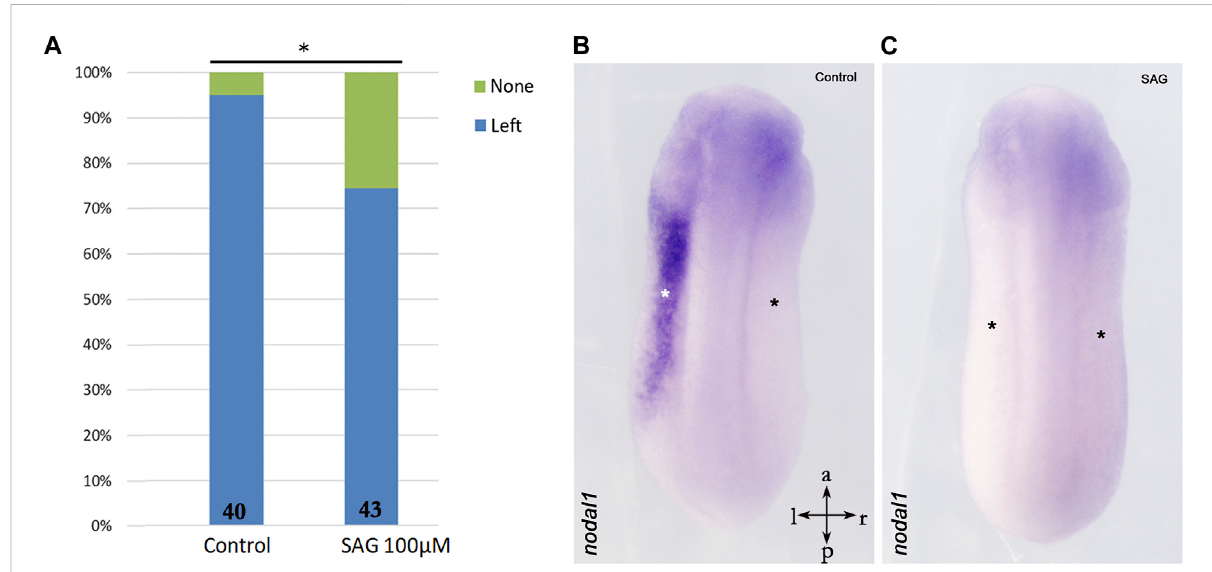
FIGURE 3 Inhibition of nodal1 expression in the lateral plate mesoderm of X. laevis embryos after treatment with an activator of hedgehog signaling. (A) Treatment with SAG leads to inhibition of nodal1 expression as compared to control embryos. (B) Example of left-sided nodal1 expression; (C) example of suppressed nodal1 expression. Intersecting arrows indicate anatomical axes. Numbers at the base of columns represent a number of analyzed embryos. * p < 0.05 (0.023) as compared to control and two-proportions